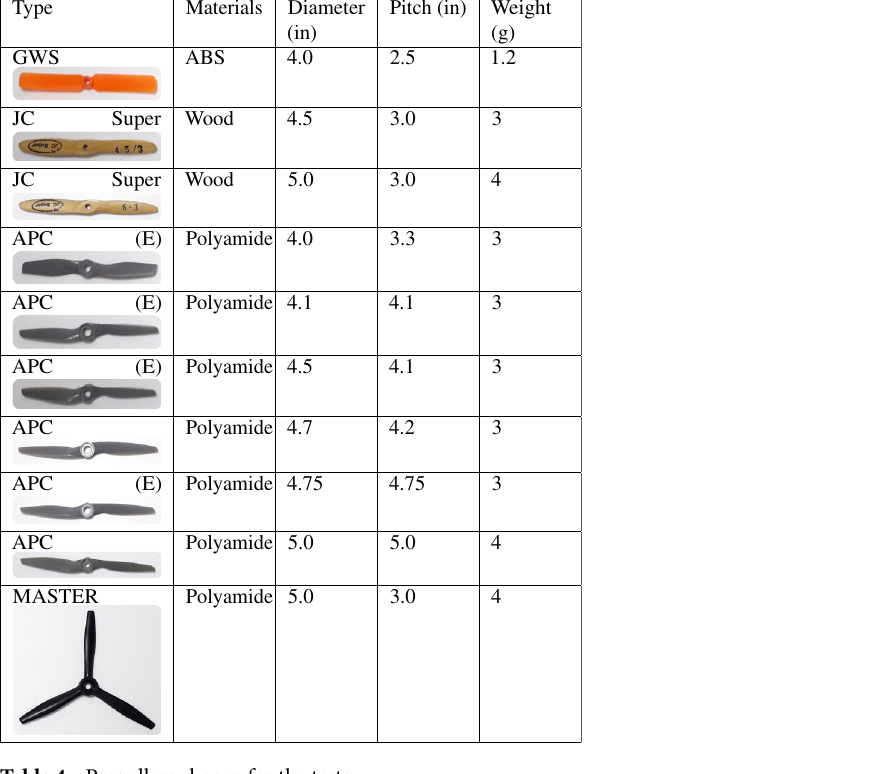
Table 4. Propellers chosen for the